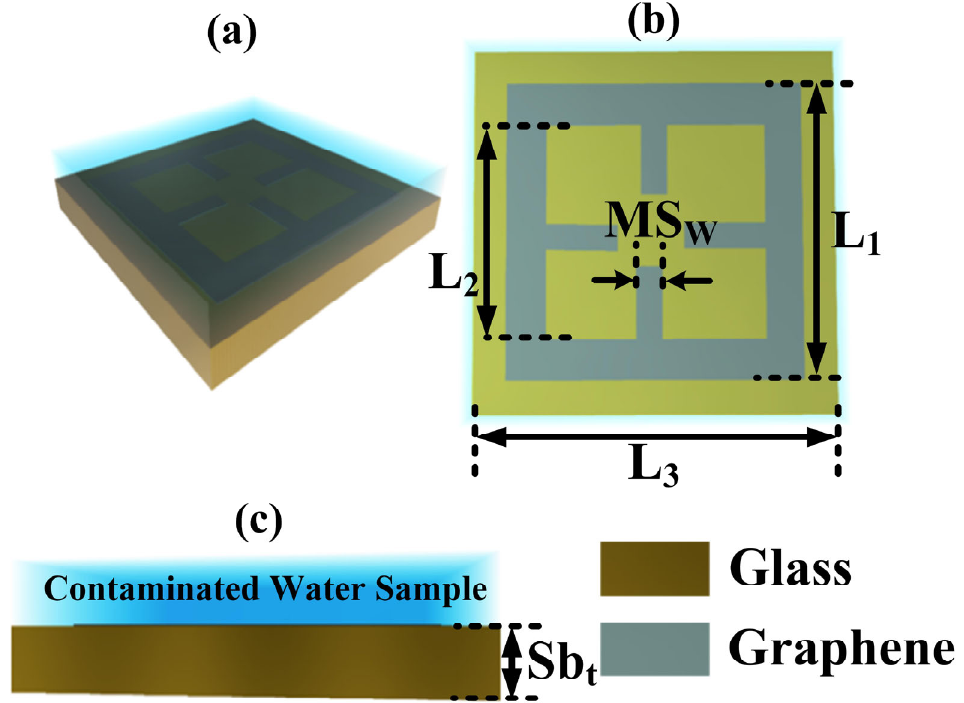
Figure 1. Developed water contamination detection graphene-metasurface-inspired sensor ( a ) structural view ( b ) top view of meta surface design with length and width. ( c ) front view of meta surface design with width. The parameters for the given structure are as follows: length of the structure L 1 is 8 µ m, L 2 is 7 µ m, and the height of graphene pattern is 0.34 nm. Width of the meta surface pattern W is 1 µ m. Length of the whole structure L 3 is 10 µ m. Thickness of the glass substrate material T 1 is 1.5 µ m.